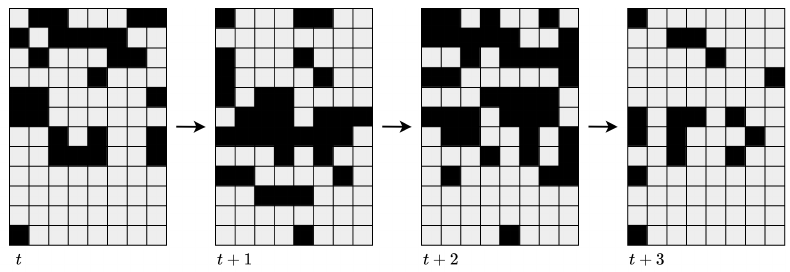
Figure 36. Cellular sequence resulting from the first four cycles of the